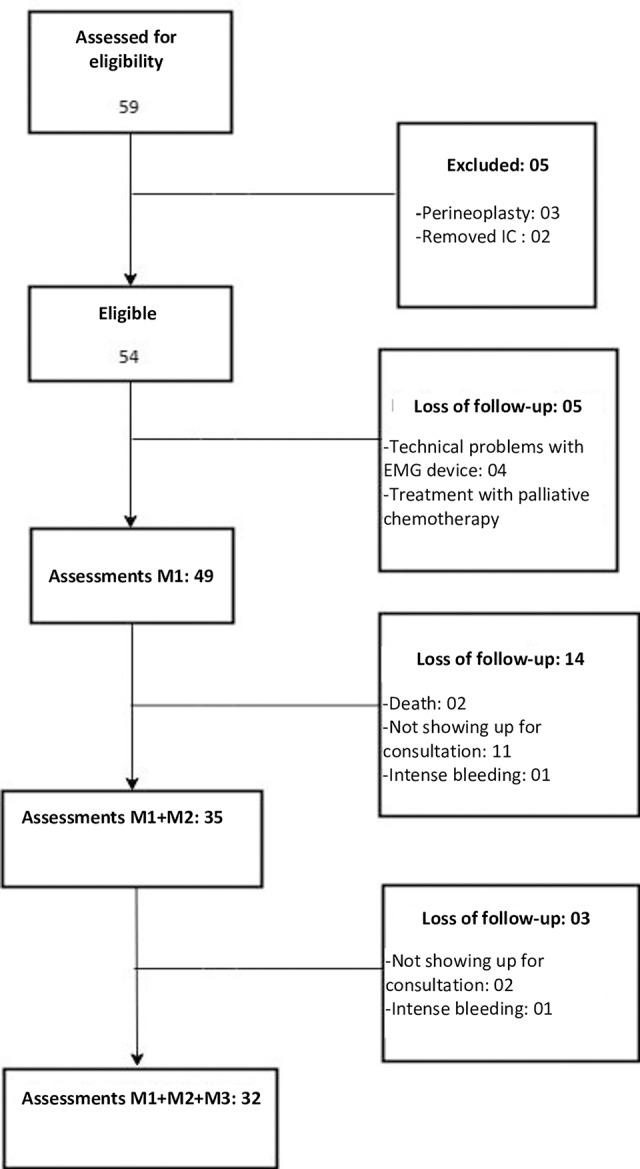
Recruitment flowchart and evaluation moments of study patients.IC: Informed Consent; EMG: Surface electromyography; M1: Evaluation at Moment 1 (before treatment); M2: Evaluation at Moment 2 (from 90 to 120 days after the end of the treatment); M3: Evaluation at Moment 3 (from 200 to 270 days after the end of the treatment.